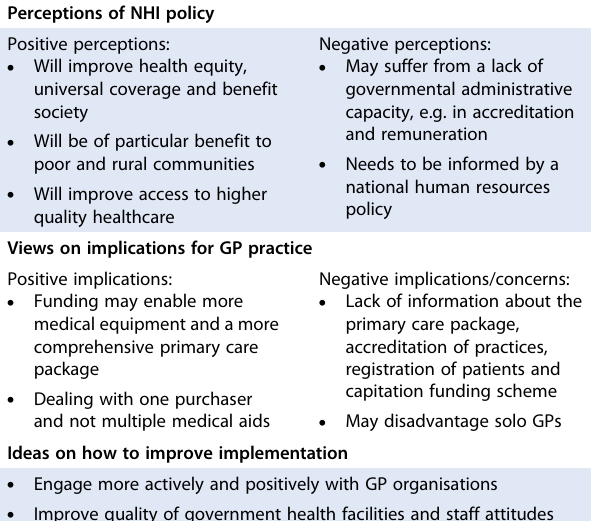
Table 2: Summary of key findings Perceptions of NHI